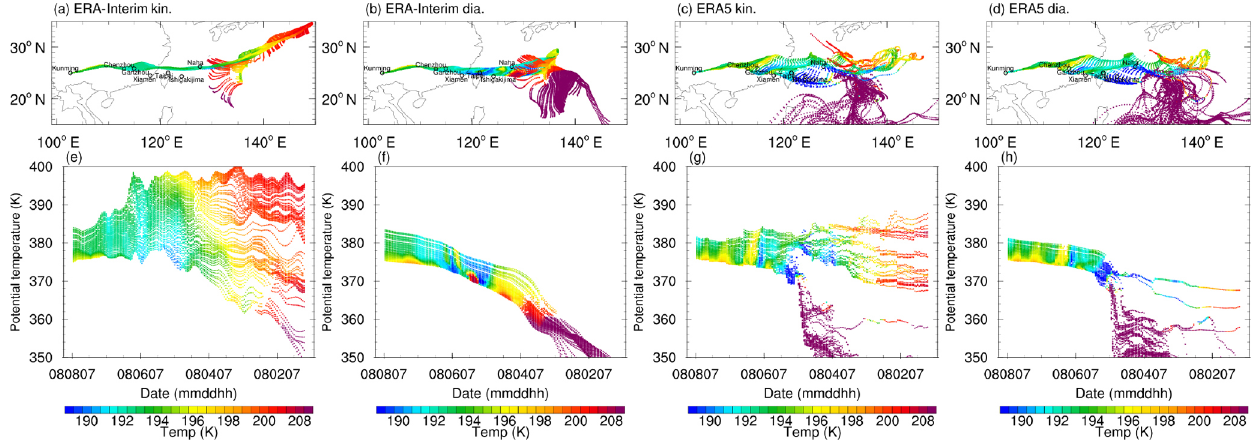
Figure 5. ERA-Interim kinematic (a, e) and diabatic (b, f) as well as ERA5 kinematic (c, g) and diabatic (d, h) 7d backward trajectories for air parcels started along the measured balloon profile between 376 and 384K colour-coded by temperature in (a–d) a longitude–latitude cross section and (e–h) as a function of time vs. potential temperature.